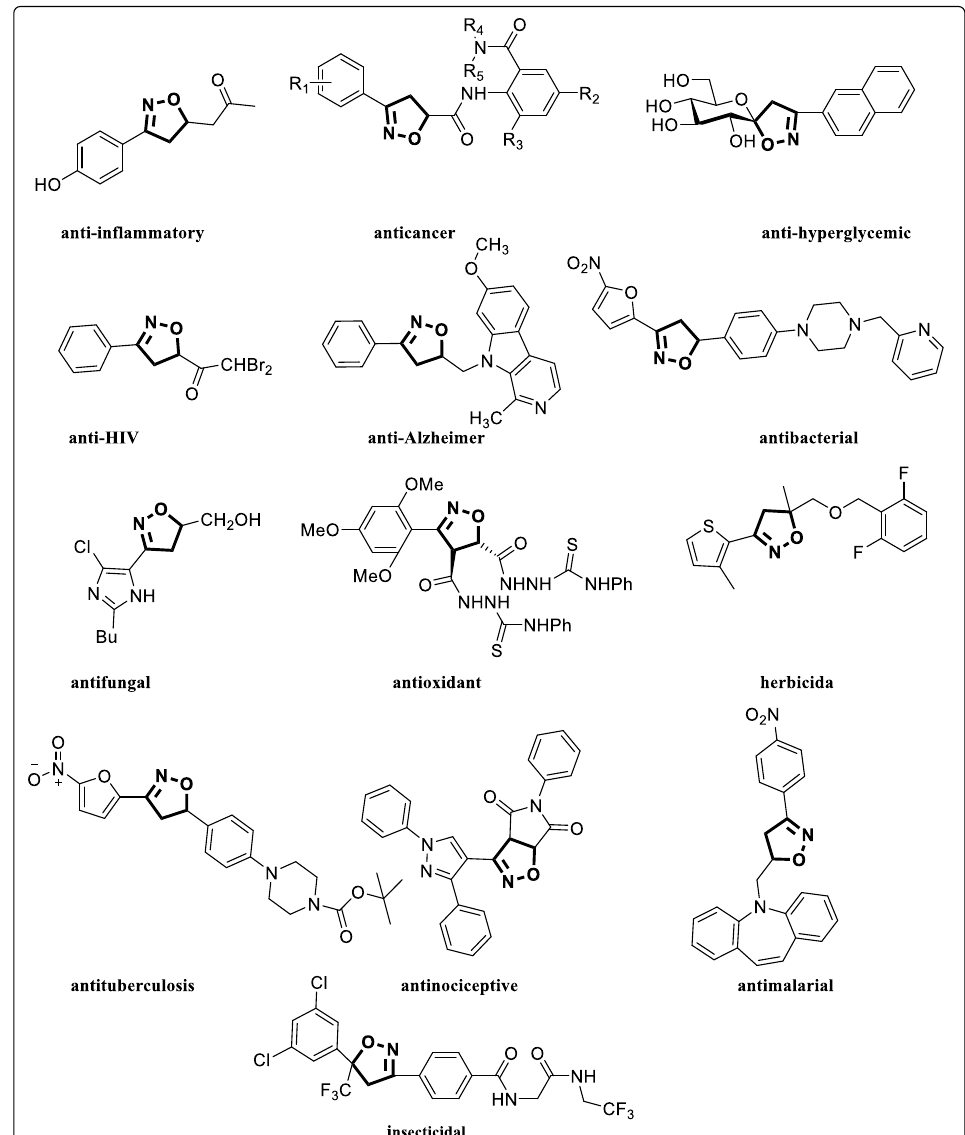
Figure 1. Structures of isooxazolines with bioactivity.